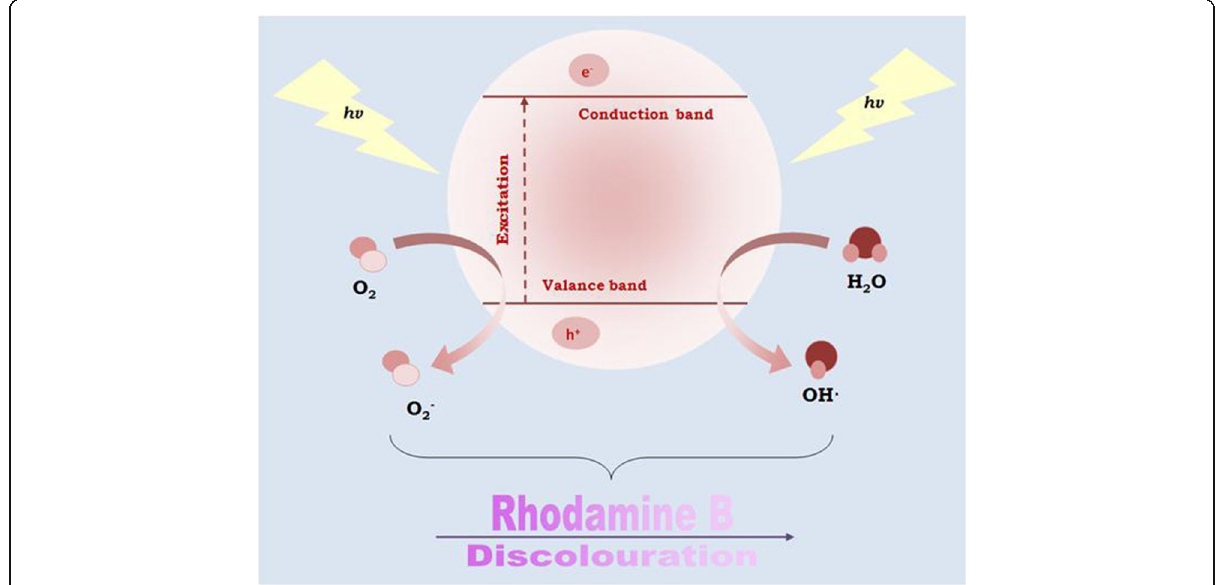
Fig. 4 Photocatalytic degradation of rhodamine B by copper oxide